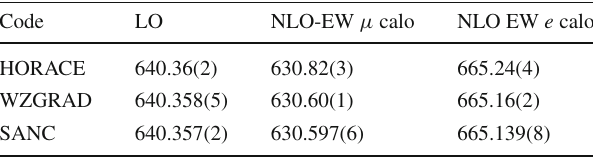
Table 16 pp → W − → l − ¯ ν l cross sections (in pb) at the 8 TeV LHC,